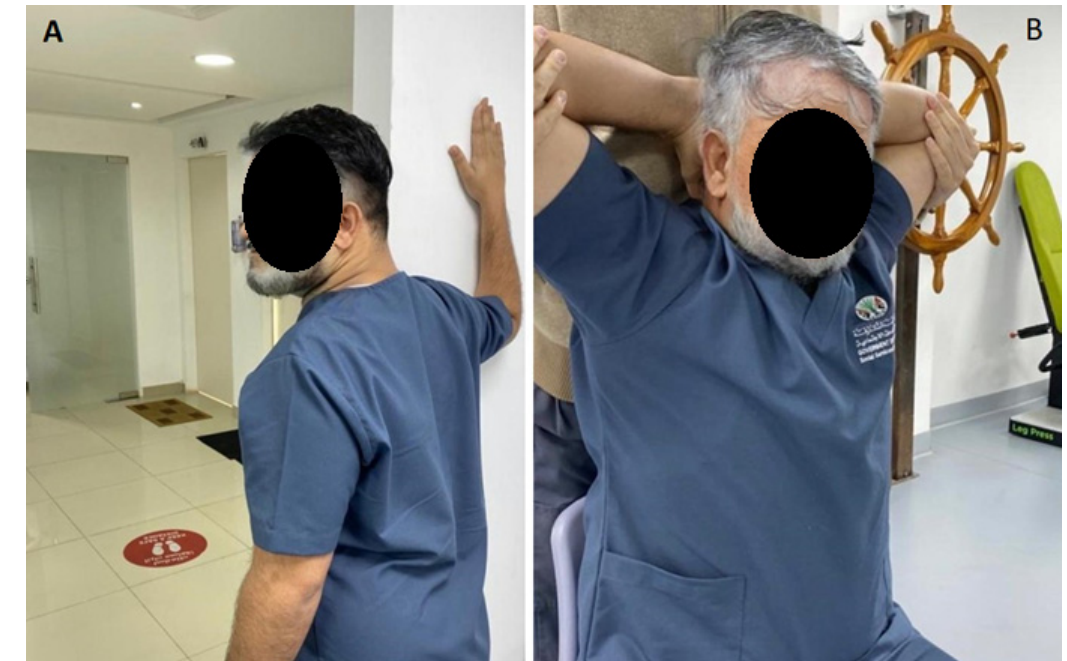
Figure 7. In ( A ) a unilateral pectoralis stretch is shown. In ( B ) a bilateral pectoralis stretch posi- tion is